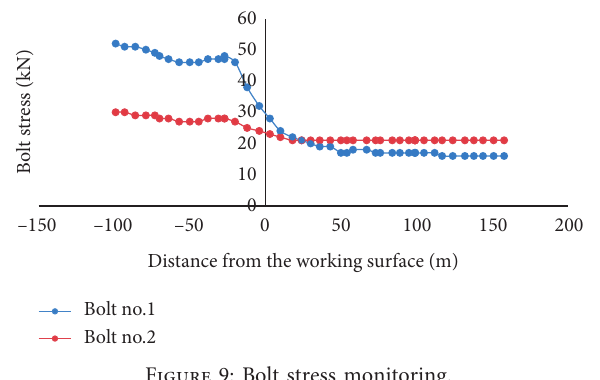
Figure 9: Bolt stress